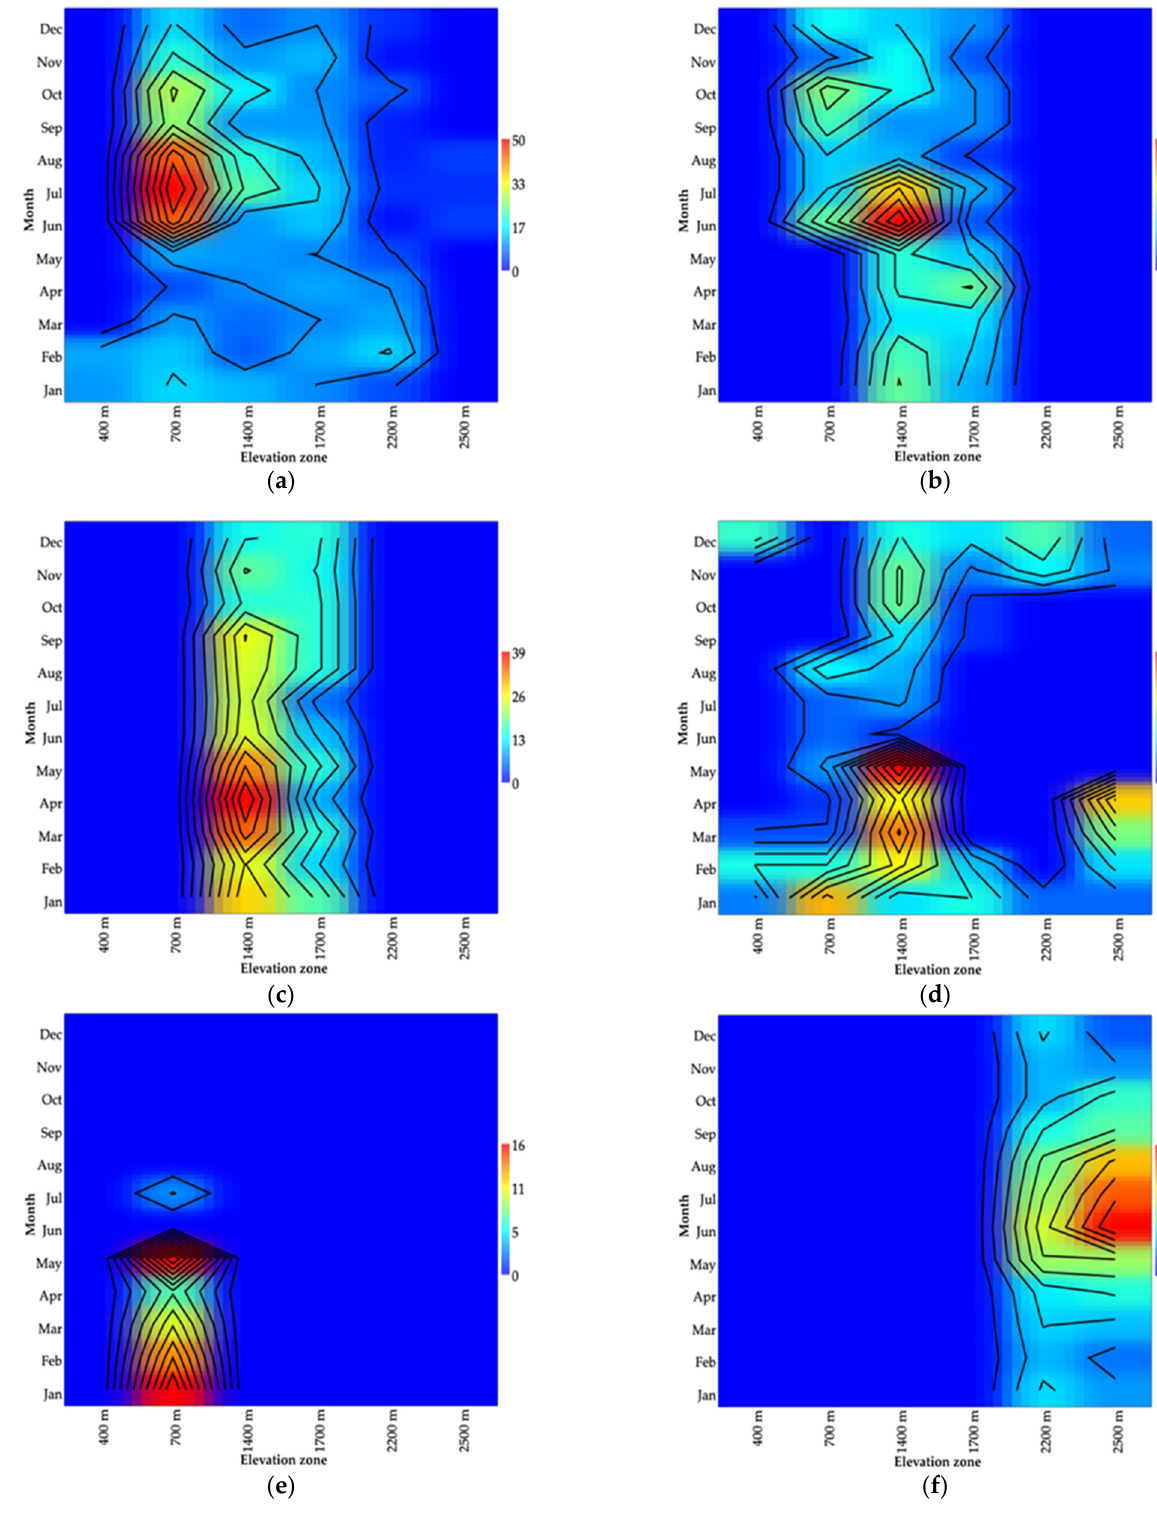
Figure 7. Spatiotemporal variation in abundance of six human-biting species collected along six elevational gradients at Doi Inthanon National Park. ( a ) Simulium asakoae species-group. ( b ) S. chamlongi . ( c ) S. doipuiense complex. ( d ) S. nigrogilvum . ( e ) S. nodosum . ( f ) S. tenebrosum